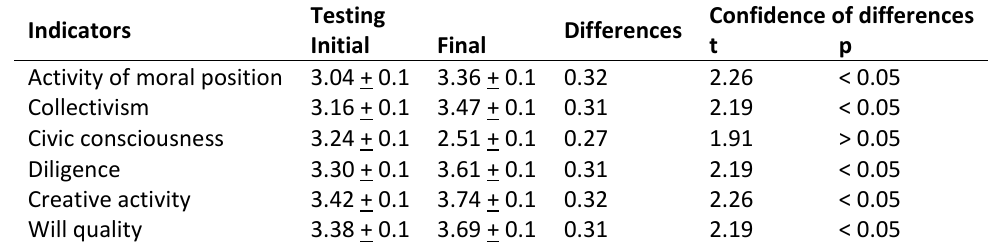
Table 5. Socially significant qualities of students (M+m) Indicators